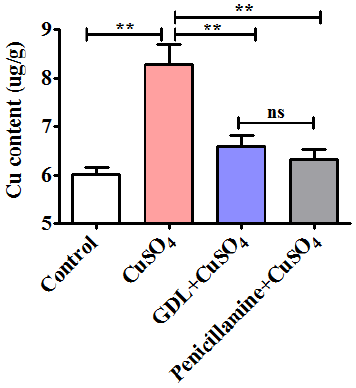
Figure 5. Effects of GDL on Cu excretion in the heart tissue. Data are presented as mean ± SEM ( n = 10). ** p < 0.01. ns: no